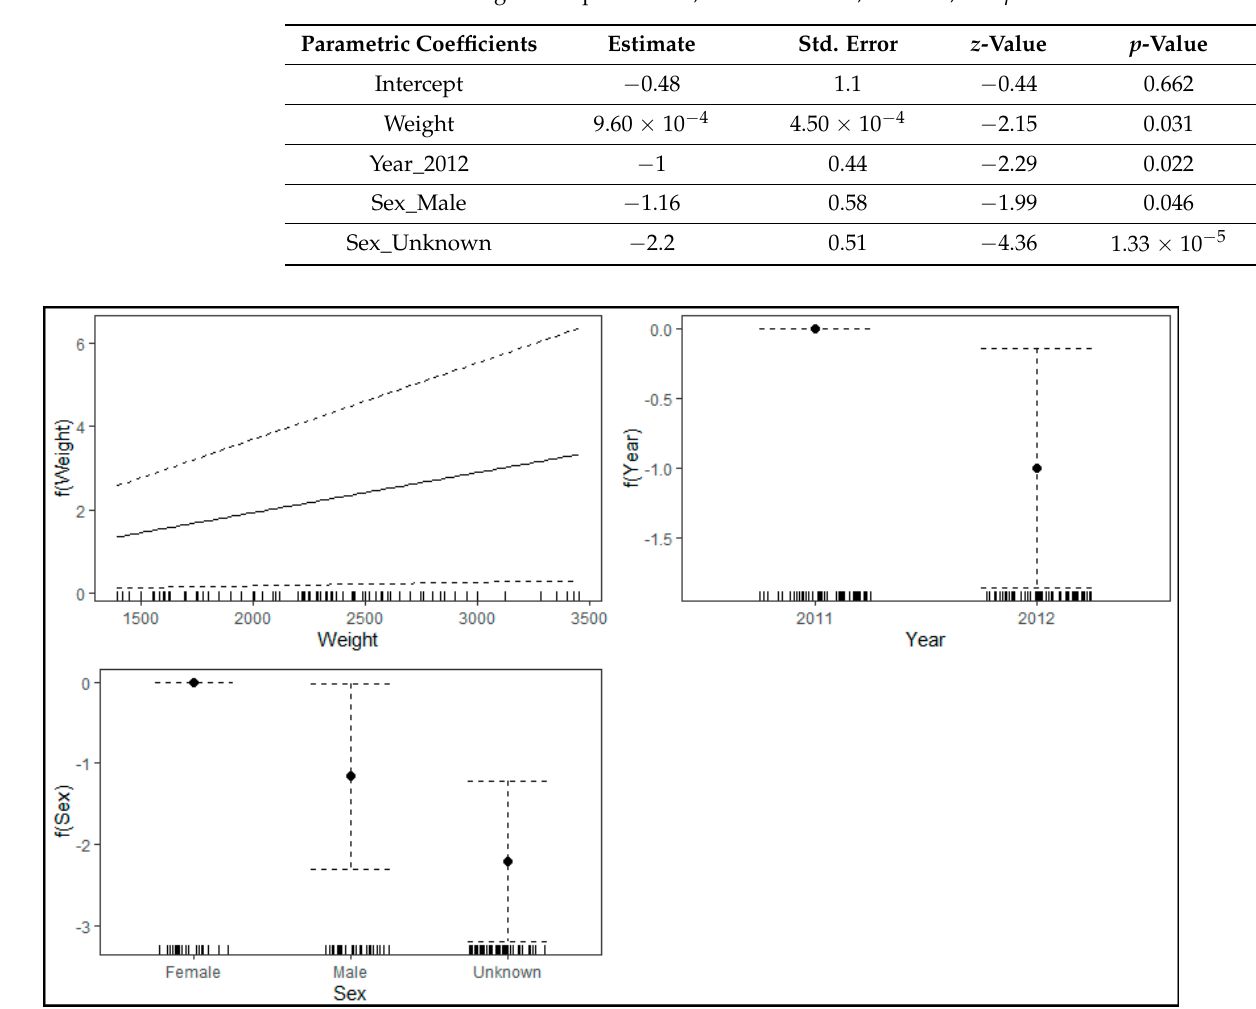
Figure 4. GAM model fit displaying lice’s abundance against host size (weight), year, and sex. Table 3. Estimated regression parameters, standard errors, z -values, and p -values for the GAM. Parametric